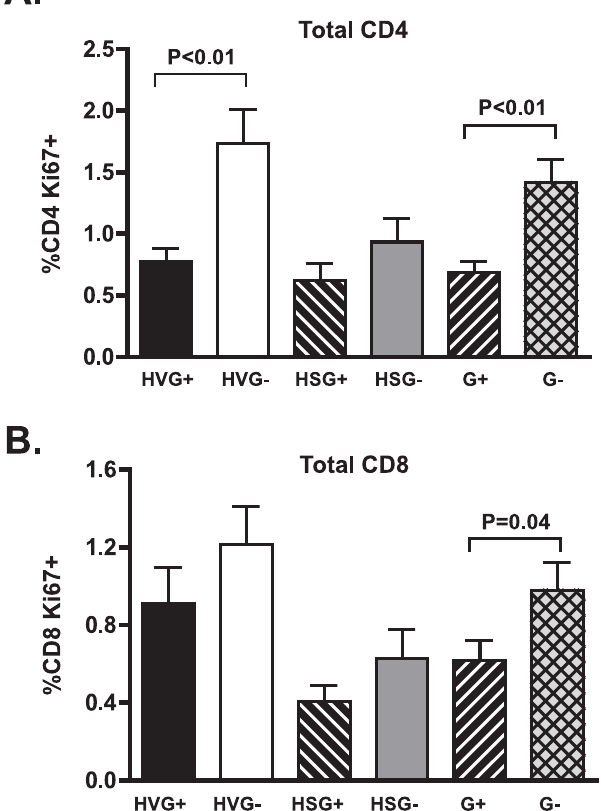
Figure 5. GBV-C is associated with reduced CD4 + and CD8 + T cell proliferation in HIV-infected individuals. The percentage of CD4 + (A) and CD8 + (B) T cells expressing the proliferation marker Ki67 differed between GBV-C viremic (G + ) subjects and those without GBV-C viremia (G-). Results of subjects not receiving combination antiretroviral therapy (HIV viremic; HV) or those with suppressed HIV RNA on therapy (HS) and statistical evaluation are provided.